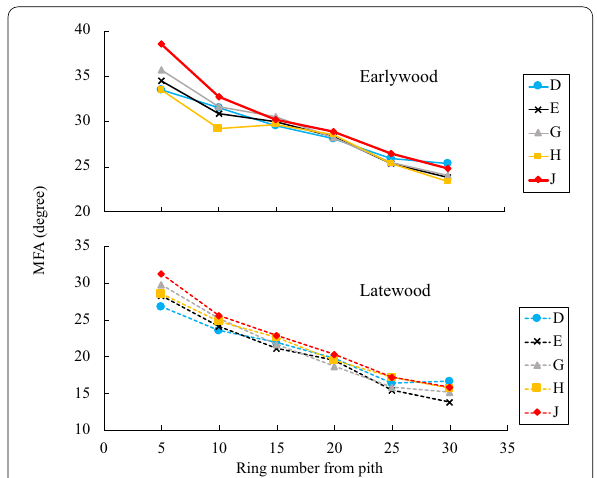
Fig. 8 Effects of initial tree density on MFA of earlywood and latewood in each ring Each plot shows an average value in a ring among five sample trees of each tree density zoning symbol. Initial